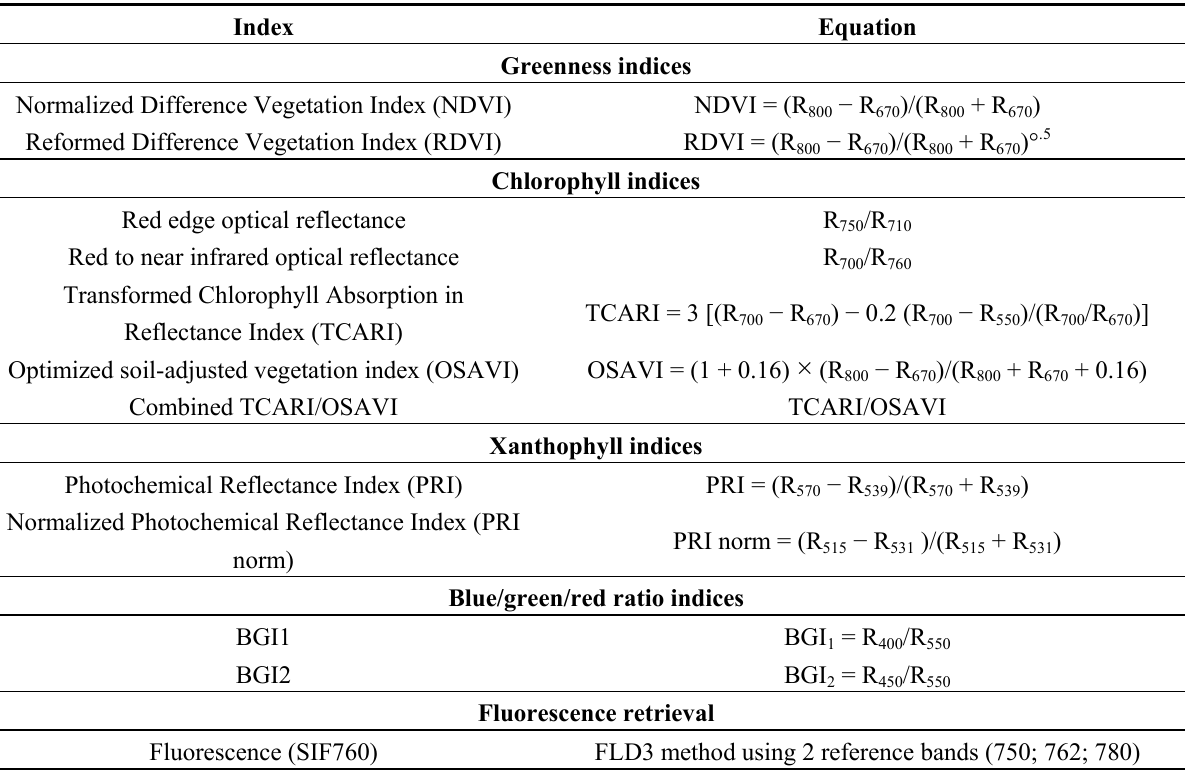
Table 2. Airborne narrow-band hyperspectral optical indices used in this study. FLD, Fraunhofer Line